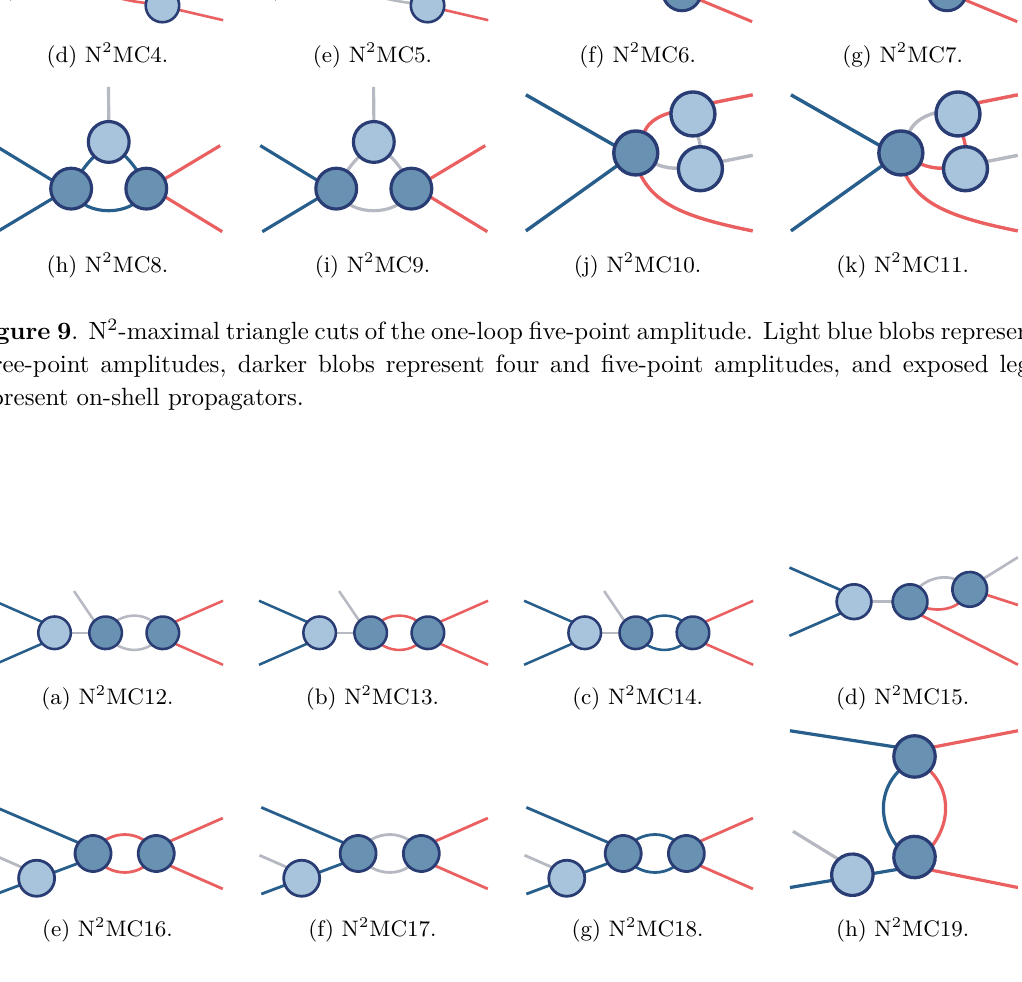
Figure 10 . N 2 -maximal cuts of the one-loop five-point amplitude. Light blue blobs represent three-point amplitudes, darker blobs represent four and five-point amplitudes, and exposed legs represent on-shell